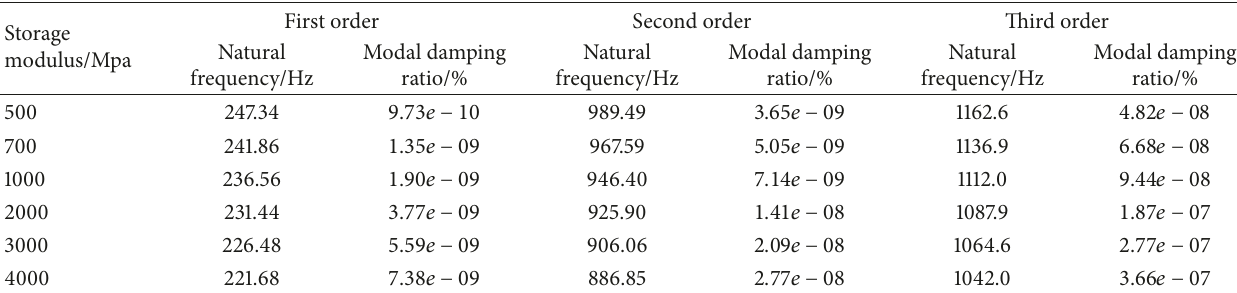
Table 8: Natural frequencies and modal damping ratios of the blade with different storage modulus.